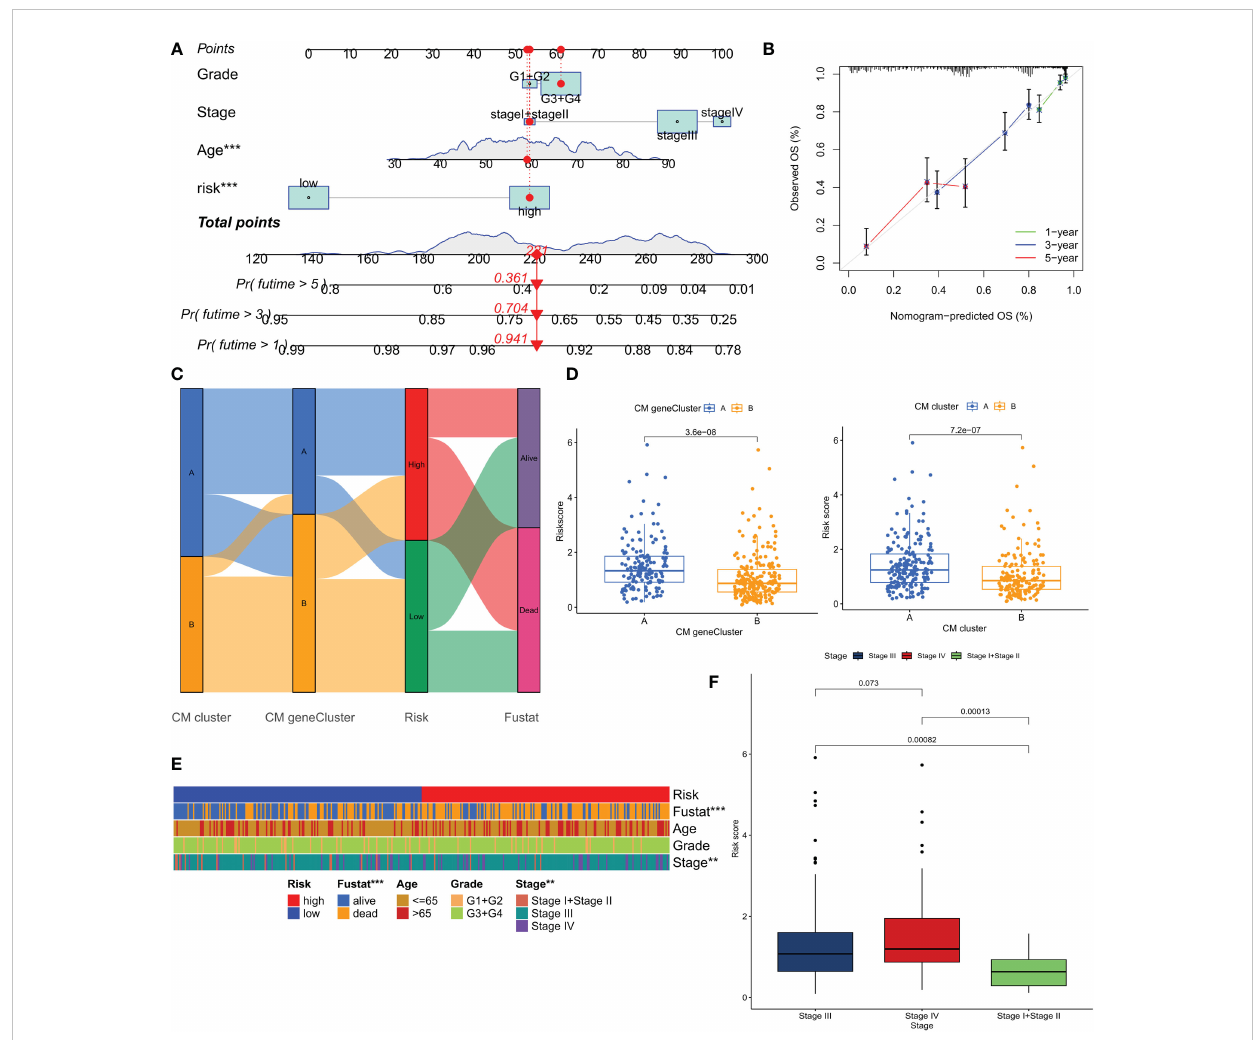
FIGURE 7 Construction and validation of nomograms for predicting OS in ovarian cancer in the TCGA cohort. (A, B) Combined nomograms and calibration curves for age, grade, and stage were used to predict OS at 1, 3, and 5 years in ovarian cancer patients. (C) Alluvial plots show the distribution of patients in 2 CM clusters, 2 CM gene clusters, 2 risk groups, and their survival status. (D) Differences in risk scores for the 2 CM clusters and the 2 CM gene clusters. (E) Heat map of clinical characteristics associated with risk clusters as determined by chi-square test. (F) Comparison of risk scores of patients at different clinical stages. **P < 0.01; ***P <